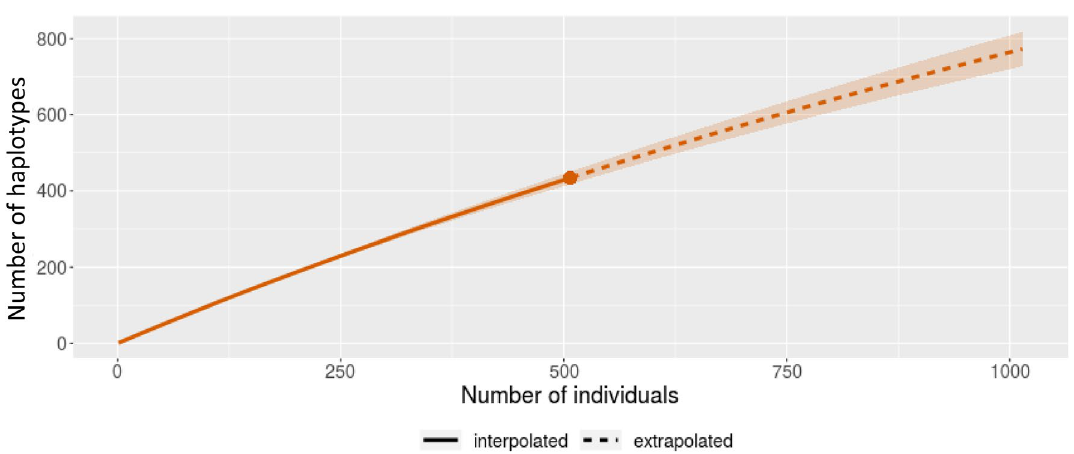
Figure 6. Relationship between the number of individuals and the number of unique haplotypes. Estimation using iNEXT from data on 507 Pacific bluefin tuna (DDBJ accession number: